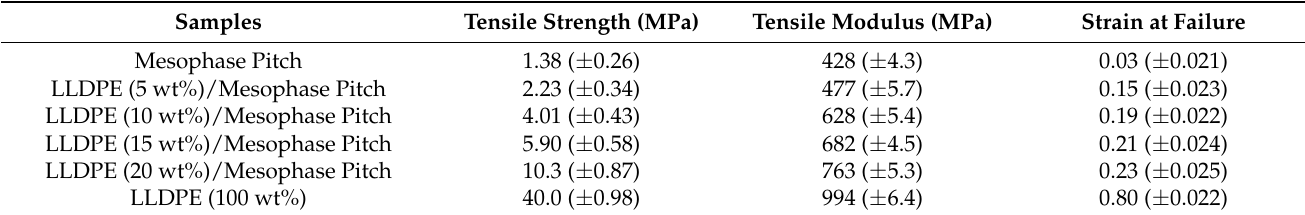
Table 3. Tensile strength, modulus, and strain at failure of the prepared